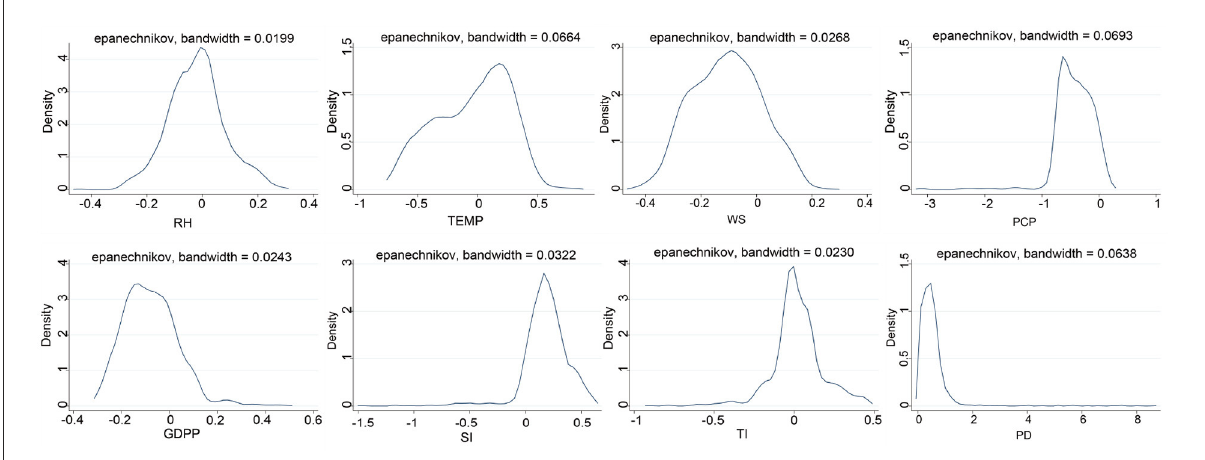
FIGURE4 Kernel density distribution of each variable coefficient.